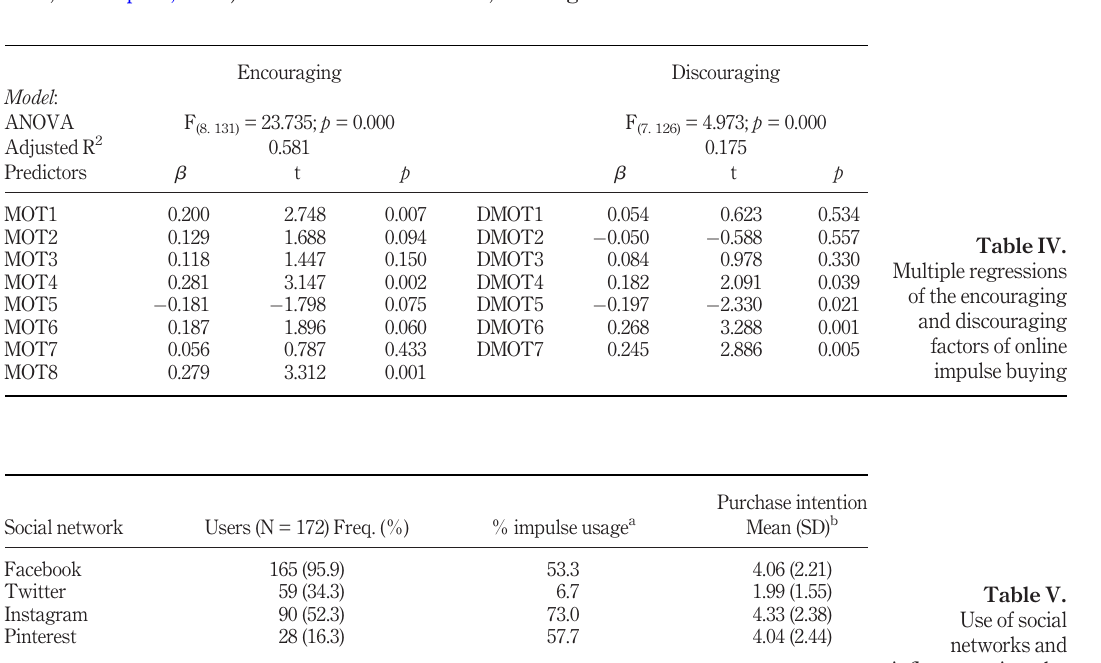
networks and influence on impulse buying of clothing and